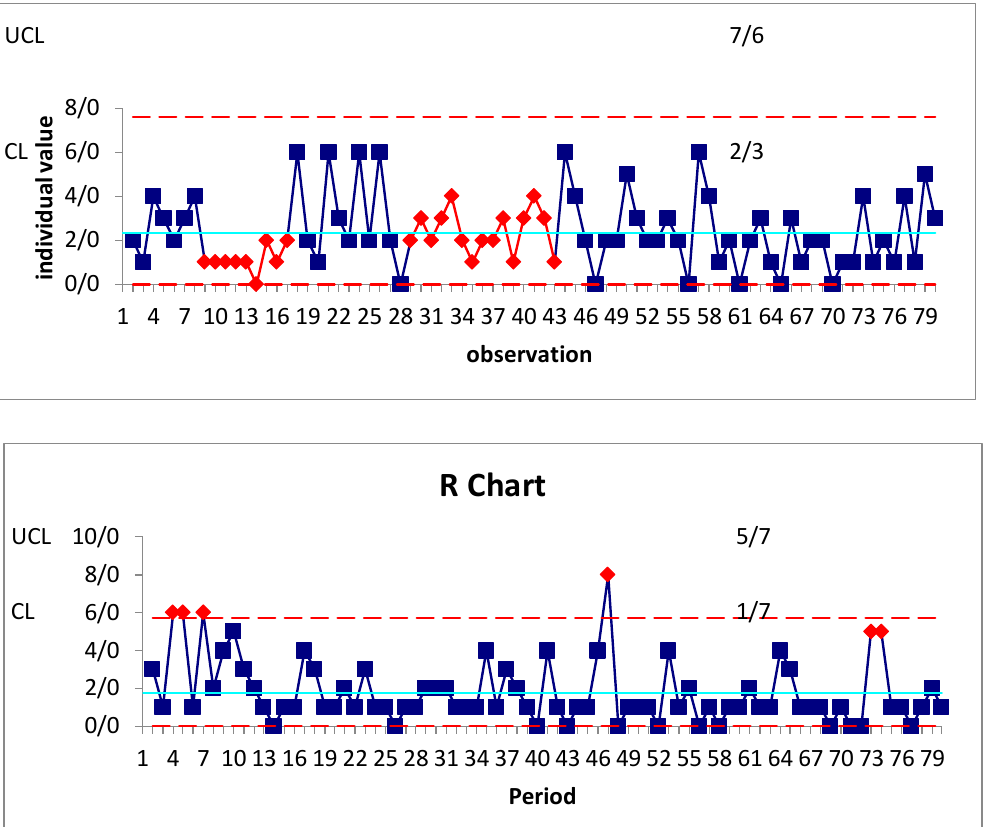
Fig. 24. R-Chart for the receiving data before improvement and after improvement.